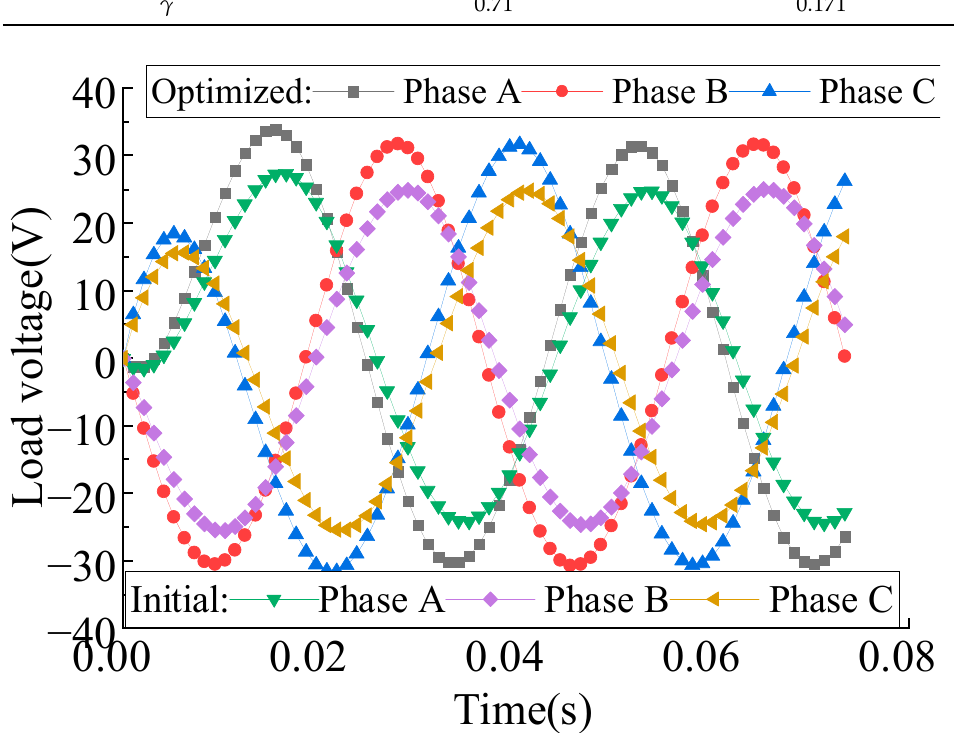
Figure 18. Comparison of load voltage.